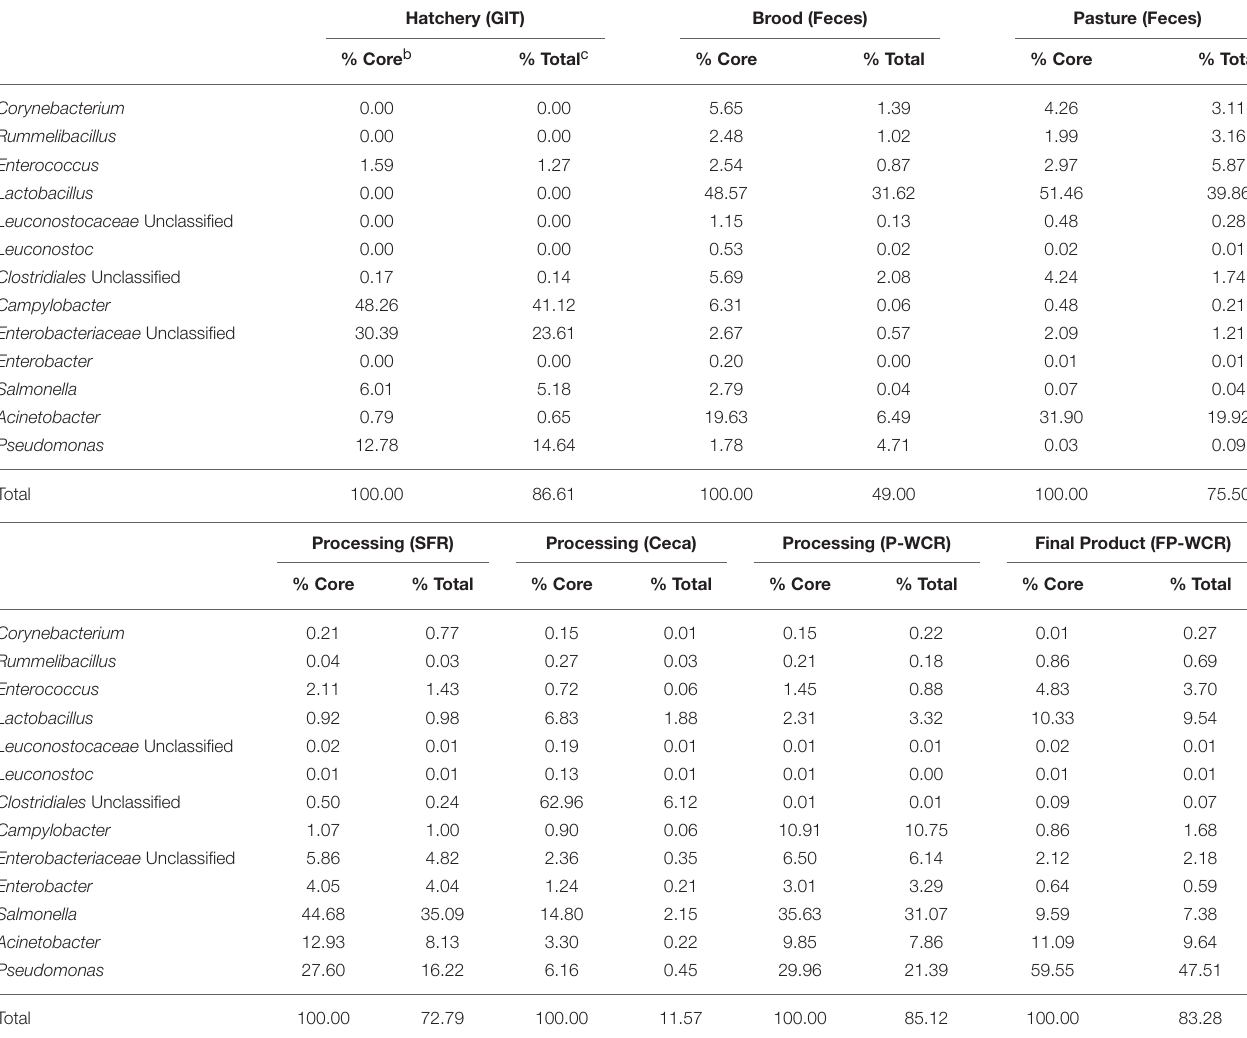
TABLE 3 | Relative abundances of the stringent core microbiome taxa (OTUs present in 75% of all samples) within the core and total microbiomes from different sample types and stages along the farm-to-fork continuum of a pasture-raised broiler flock a,b